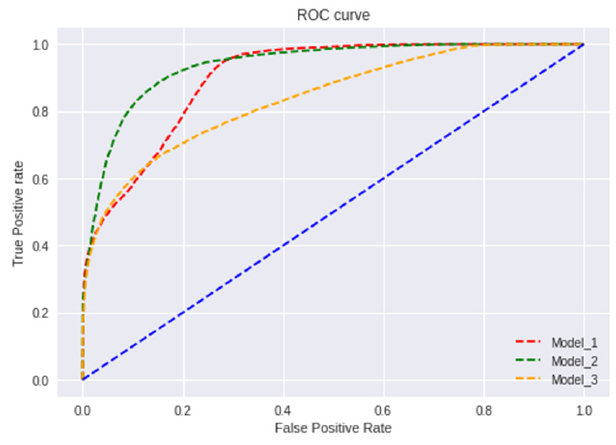
Figure 12. Receiver operating characteristic curve (ROC).